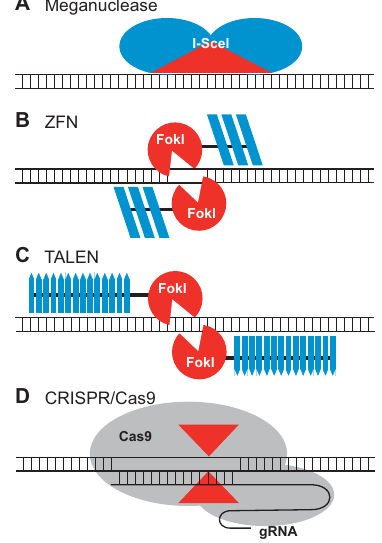
Figure 1. Schematics of the four classes of sequence-specific nucleases. (A) The meganuclease, I-SceI, is shown bound to its DNA target. The catalytic domain, which also determines DNA sequence specificity, is shown in red. (B) A ZFN dimer is illustrated bound to DNA. ZFN targets are bound by two zinc-finger DNA binding domains (dark blue) separated by a 5–7-bp spacer sequence. FokI cleavage occurs within the spacer. Each zinc finger typically recognizes 3 bp. (C) Depicted is a TALEN dimer bound to DNA. The DNA binding domains are in dark blue. The two TALEN target sites are typically separated by a 15–20-bp spacer sequence. Like ZFNs, the TAL effector repeat arrays are fused to FokI. Each TAL effector motif recognizes one base. (D) The CRISPR/Cas9 system recognizes DNA through base pairing between DNA sequenc- es at the target site and a CRISPR-based guide RNA (gRNA). Cas9 has two nuclease domains (shown by red arrowheads) that each cleave one strand of double-stranded DNA.